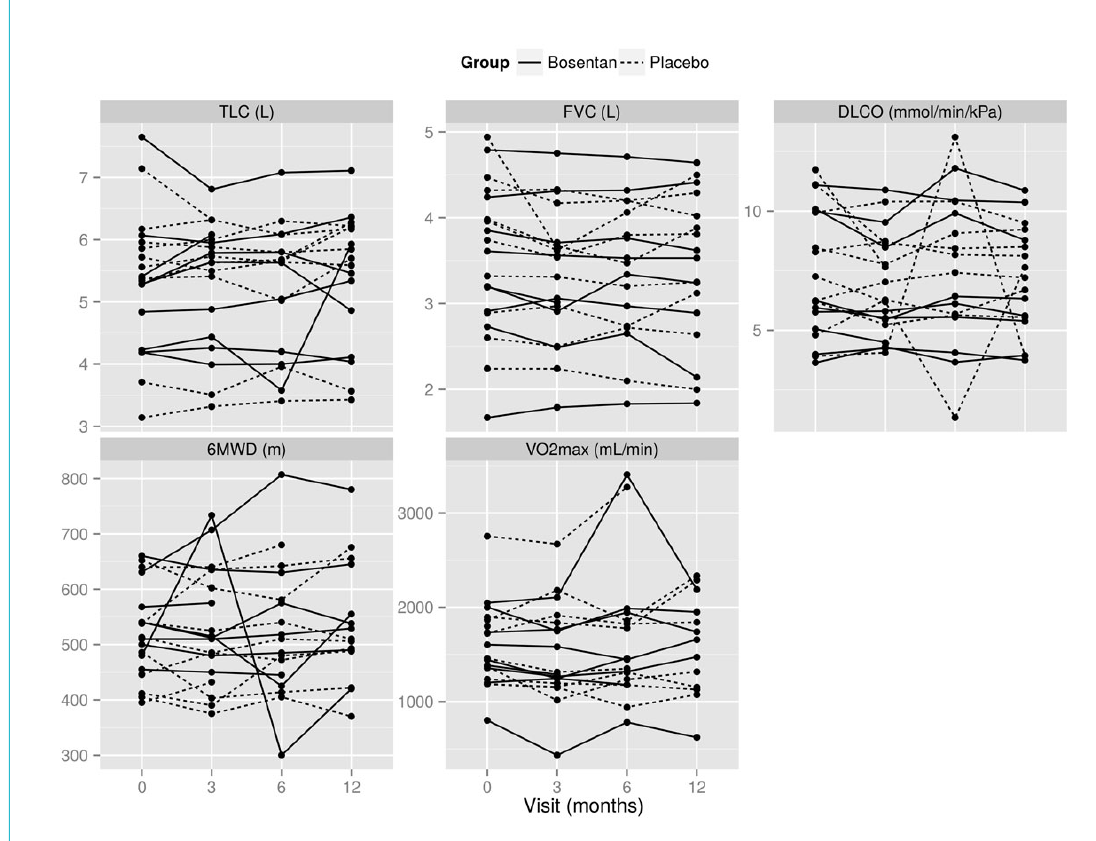
Figure 4: All individual values at baseline and months 3, 6 and 12 for total lung capacity (TLC), forced vital capacity (FVC), diffusion capacity of the lung for carbon monoxide (DLCO), 6-minute walking distance (6MWD), and maximal oxygen uptake (VO 2 max).